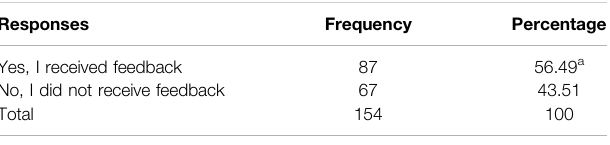
TABLE 9 | Stability of internet connection (n (cid:1)